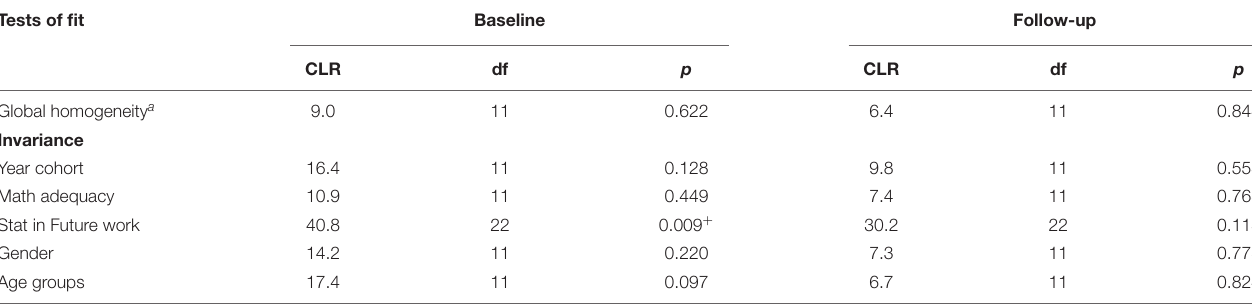
TABLE 1 | Global tests of homogeneity and invariance for the Critical Thinking Scale at baseline and follow-up. Tests of fit